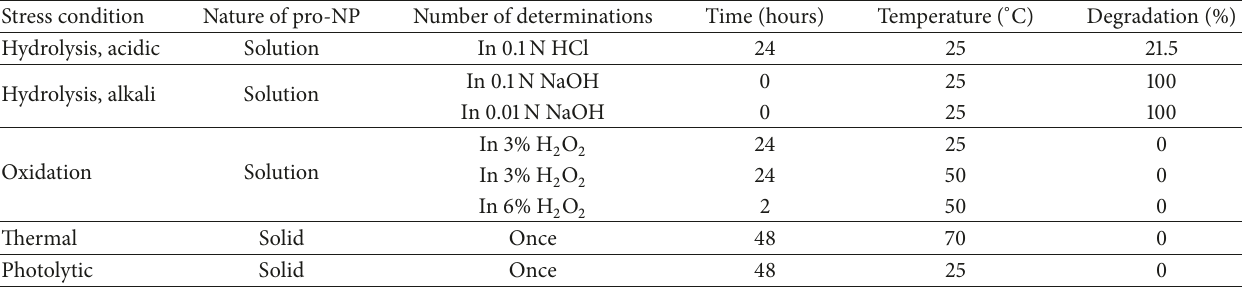
Table 2: Results of forced degradation stability studies.